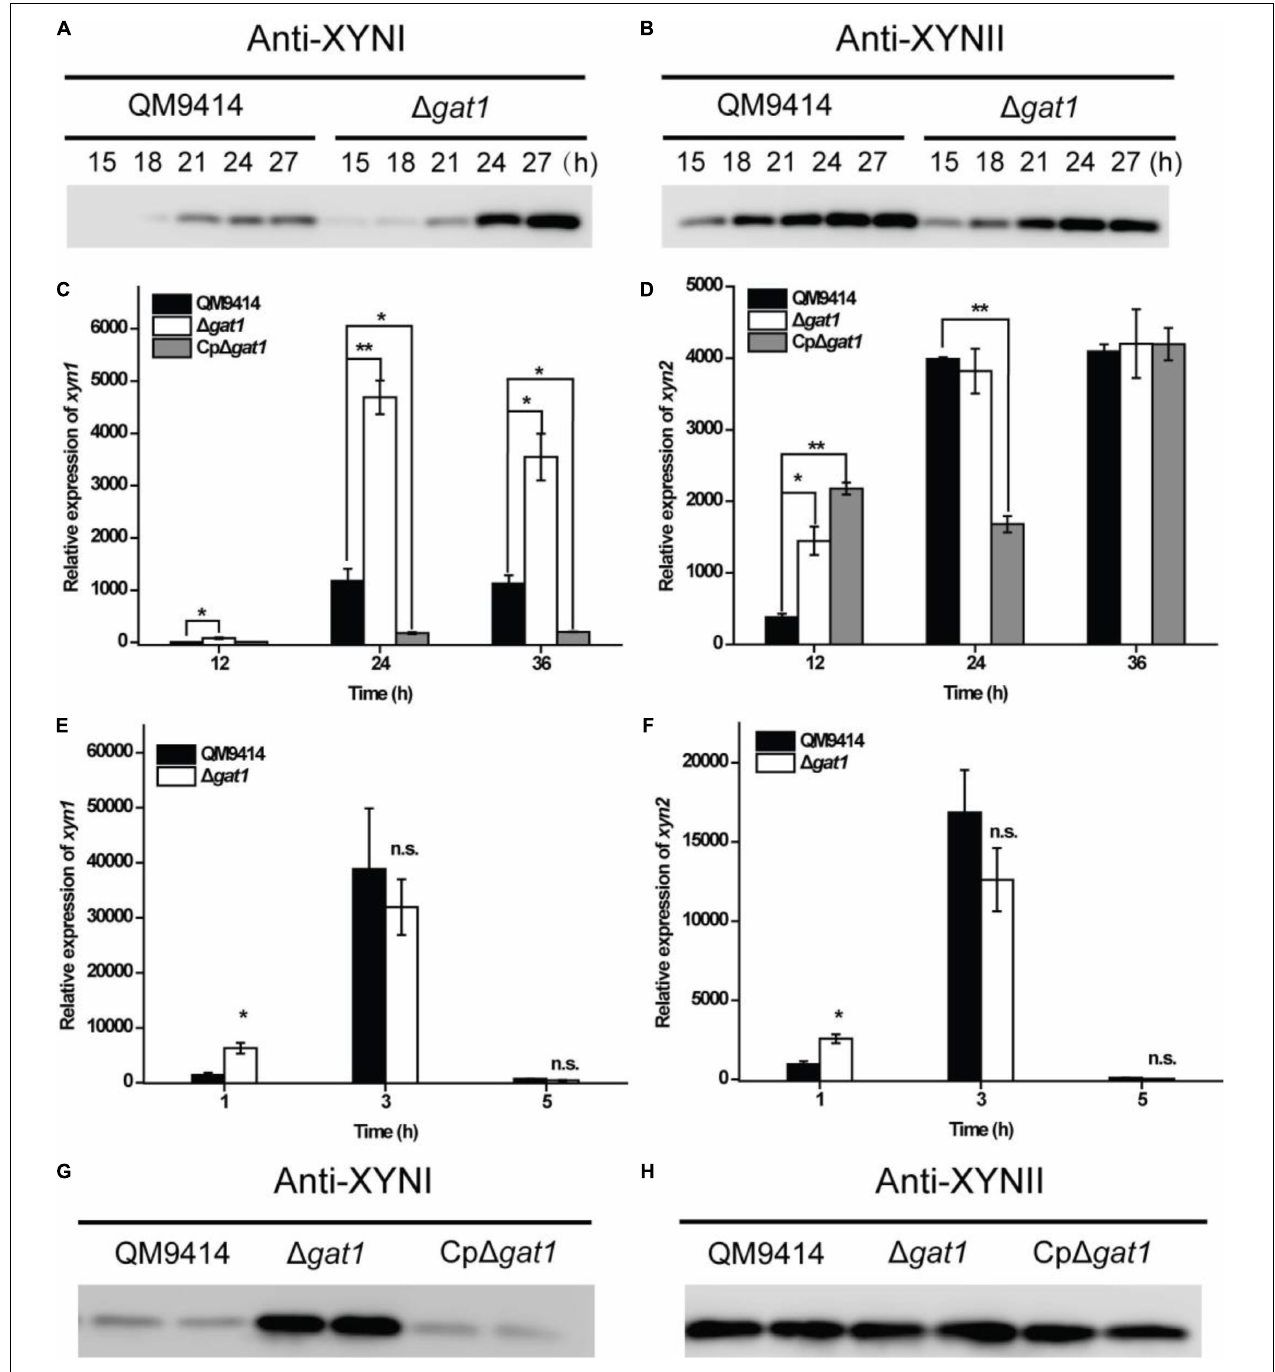
FIGURE 4 | Deletion of gat1 predominantly increased XYNI production but exerted a minor effect on XYNII synthesis. (A,B) Western blot analyses of XYNI (A) and XYNII (B) production in the culture supernatant of QM9414 and (cid:49) gat1 that were cultivated on 0.5% xylan for the indicated time periods. (C,D) Quantitative RT-PCR analyses of the relative transcriptional levels of xyn1 (C) and xyn2 (D) of QM9414, (cid:49) gat1 and Cp (cid:49) gat1 cultivated on xylan. (E,F) Quantitative RT-PCR analyses of the relative transcriptional levels of xyn1 (E) and xyn2 (F) of QM9414 and (cid:49) gat1 cultivated on 0.5 mM xylose. (G,H) Western blot analyses of XYNI (G) and XYNII (H) production in the culture supernatant of QM9414, (cid:49) gat1 , and Cp (cid:49) gat1 cultivated on xylan for 60 h. Values in this figure are the mean of three biological replicates. Error bars are the SD from these replicates. Significant differences ( t -test, * P < 0.05, and ** P < 0.01) were detected in the transcription of xyn1 or xyn2 between QM9414 and (cid:49) gat1 , or between QM9414 and Cp (cid:49) gat1 . No significant difference (n.s.) was observed in the transcription level of xyn1 or xyn2 between QM9414 and (cid:49) gat1 after cultivation on 5 mM xylose for 3–5 h. For western blot analyses, equal amounts of culture supernatant were loaded for all strains. Three independent assays with quite similar results were performed and one representative figure is